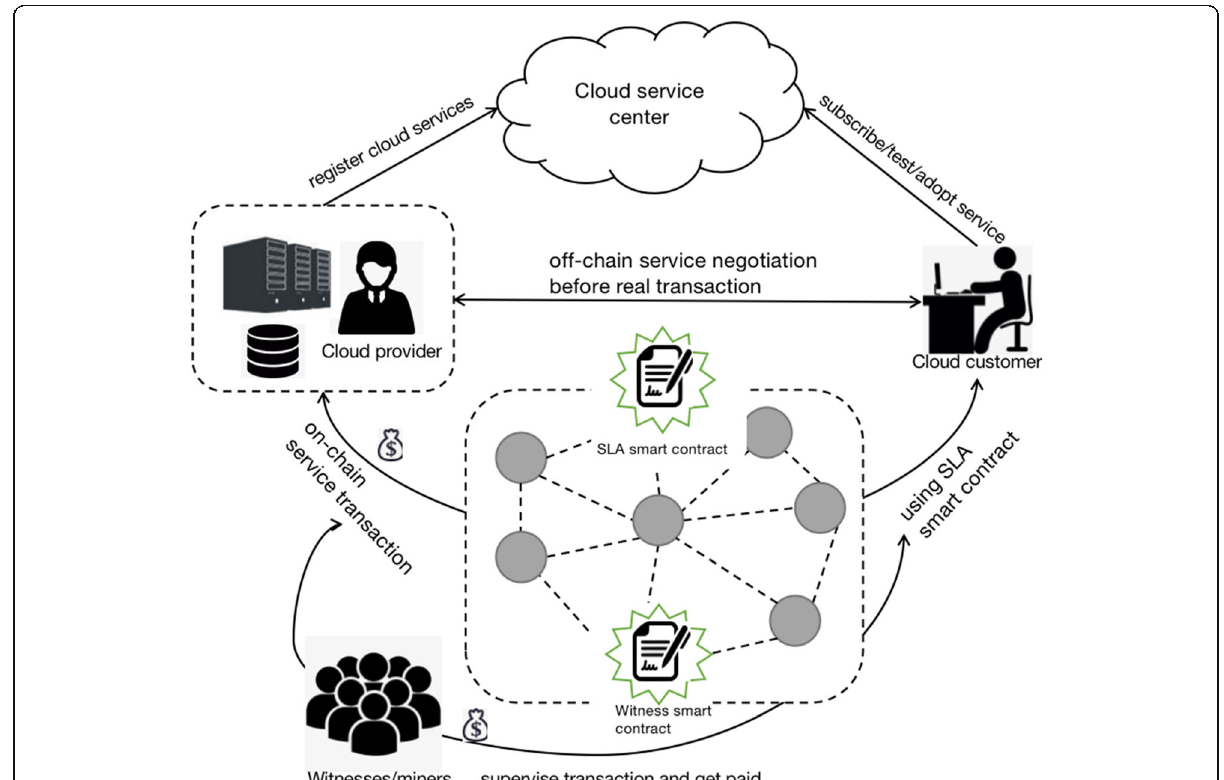
Fig. 5 Witness-contained cloud service interaction protocol